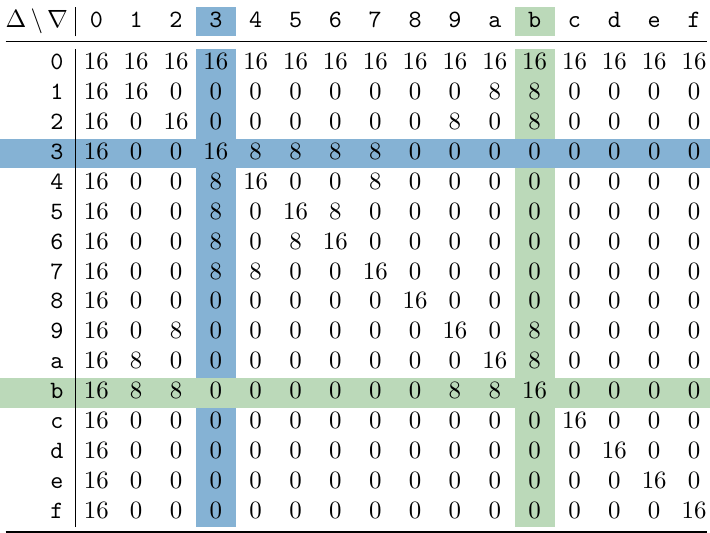
Table 7: FBCT of S-box S i in LBlock for 0 ≤ i ≤